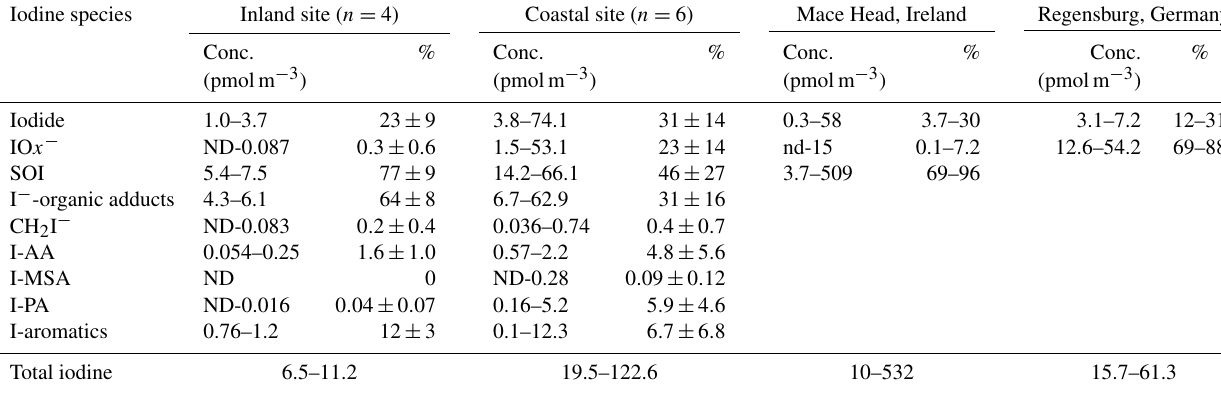
Table 2. Comparison of iodine species in PM 2 . 5 between the inland urban site and the coastal site. Iodide: the sum of I − , I − complexes (if present). IO − x : the sum of IO − , IO − , and IO − ; SOI: soluble organic iodine that is calculated as the difference between total io- 3 2 dine and the sum of iodide and IO − x . I-AA: the sum of iodoacetic acid and diiodoacetic acid; I-PA: iodopropenoic acid; I-MSA: iodomethane- sulfonic acid; CHI − : diiodomethane; I-aromatics: total aromatic iodine compounds; I − -organic adducts: iodide–organic adducts. Also shown 2 are iodine species measured by IC-ICP-MS at Mace Head (Gilfedder et al., 2008), an Irish coastal site, and Regensburg (Wimschneider and Heumann, 1995), an inland site of southern Germany. %: the percentages of iodine species in total iodine. ND: not